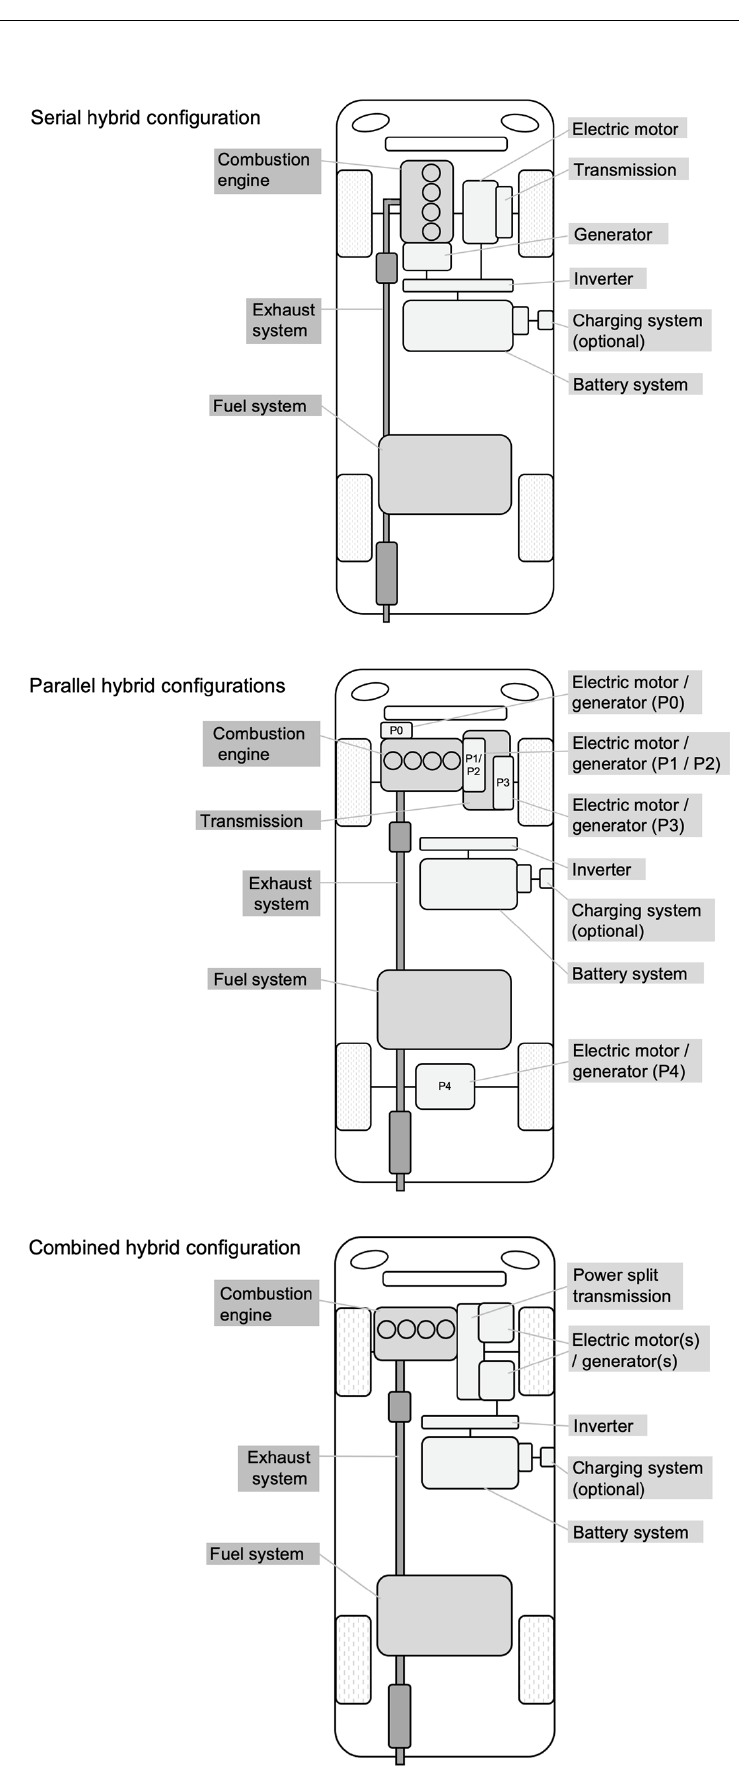
Figure 11. Powertrain architectures of hybrid cars.